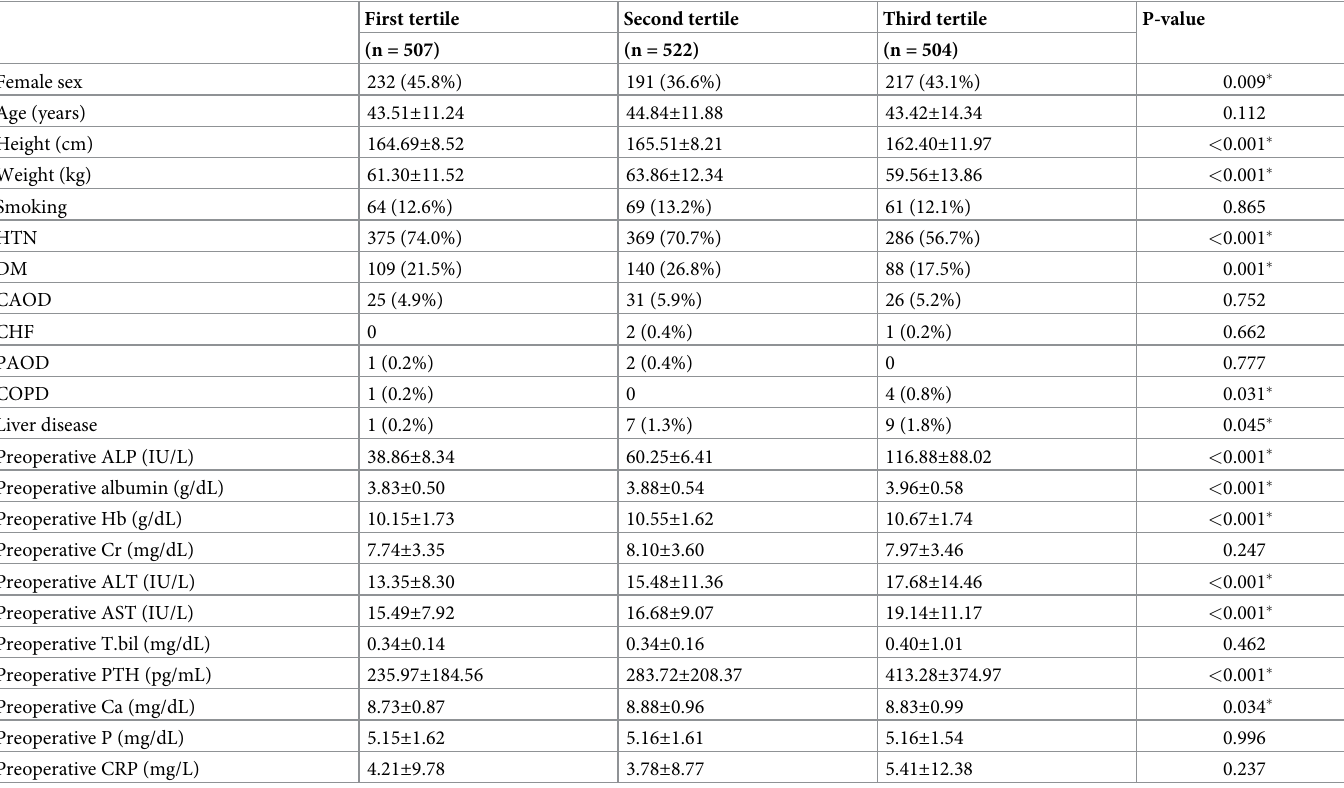
Table 1. Baseline characteristics of patients who underwent kidney transplantation. First tertile Second tertile Third tertile